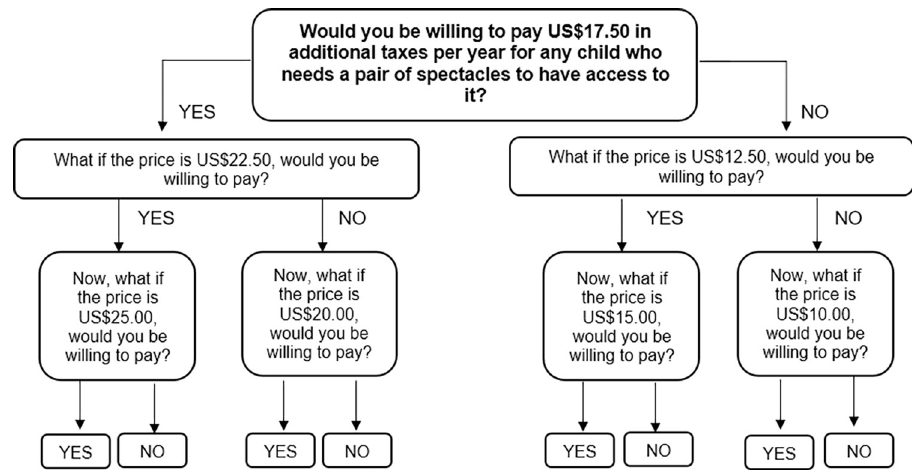
Fig 2. Survey questions route, using starting bid of US$17.50 as an